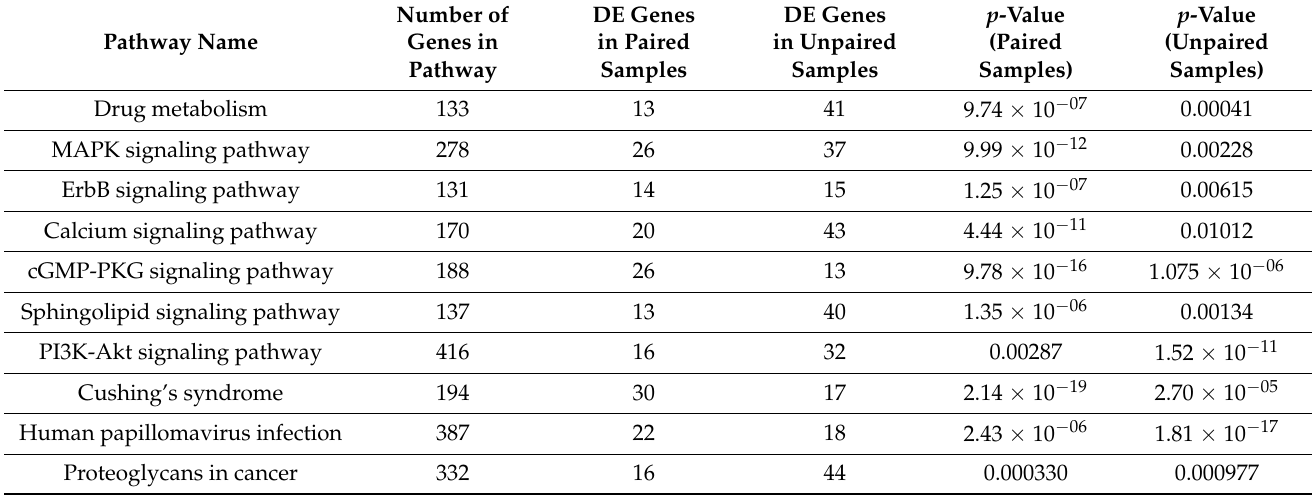
Table 4. Pathway analysis of upregulated genes in paired and unpaired sample cohorts. *